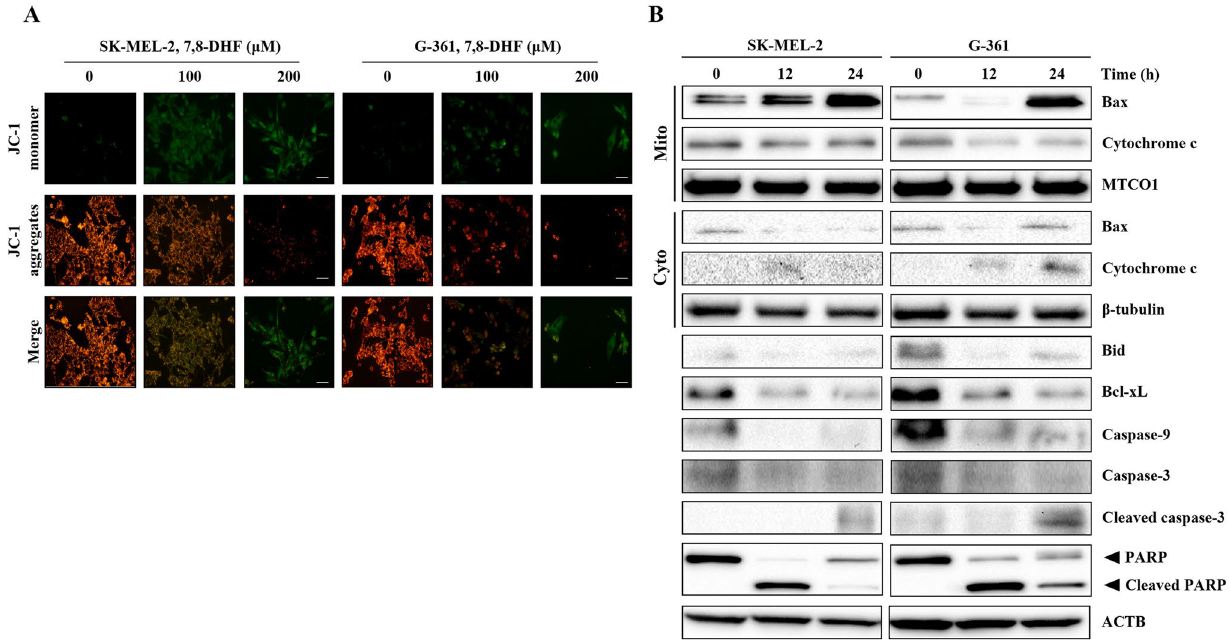
Fig. 4 Changes in the mitochondrial membrane potential of malignant SK-MEL-2 and G-361 melanoma cells. A Mitochondrial membrane depolarization by using JC-1 staining was determined through the immunofluorescence microscopy. Melanoma SK-MEL-2 (1.0 × 10 5 cells/ well) and G-361 cells (1.0 × 10 5 cells/well) were treated with 7,8-DHF (100 and 200 µM) for 24 h and mitochondrial membrane depolarization was found to increase in a dose-dependent manner. B The mitochondrial apoptotic process in SK-MEL-2 and G-361 cells was determined by western blot analysis of mitochondrial and cytosolic protein levels. The mitochondrial fraction was confirmed using the mitochondrial marker MTCO1, and the cytosolic fraction was confirmed using β-tubulin. 7,8-DHF induced Cytochrome c release and Bax expression. 7,8- DHF decreased BID, BCL- L, Caspase 9, CASP3, and PARP expression time-dependently. Cyto, cytosolic fraction; Mito, mitochondrial X